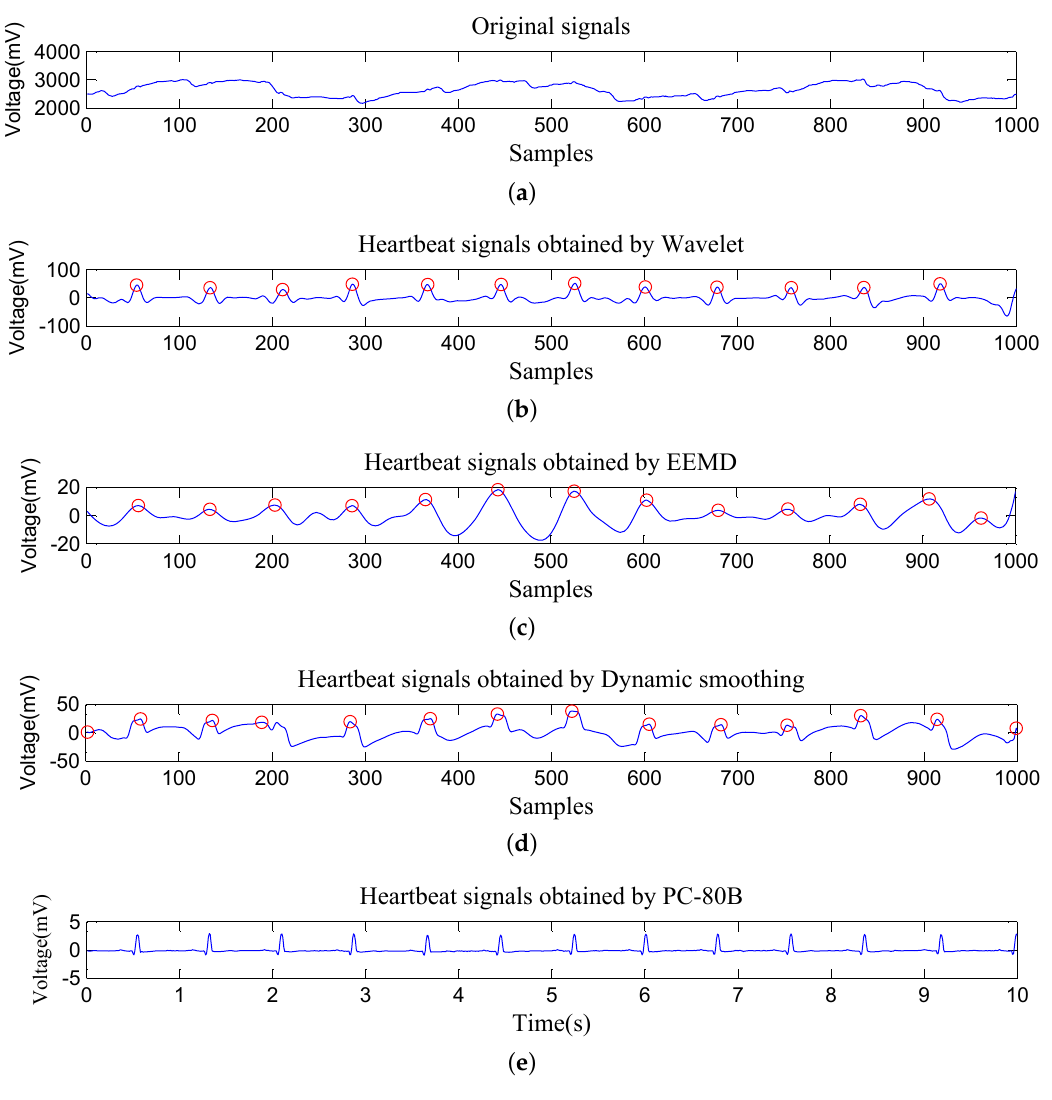
Figure 6. An illustration of original signals and heartbeat signals obtained by different methods. ( a ) Original signals captured by the piezoelectric ceramic sensor, ( b ) Heartbeat signals obtained by Wavelet analysis, ( c ) Heartbeat signals obtained by EEMD, ( d ) Heartbeat signals obtained by Dynamic smoothing, ( e ) Heartbeat signals obtained by